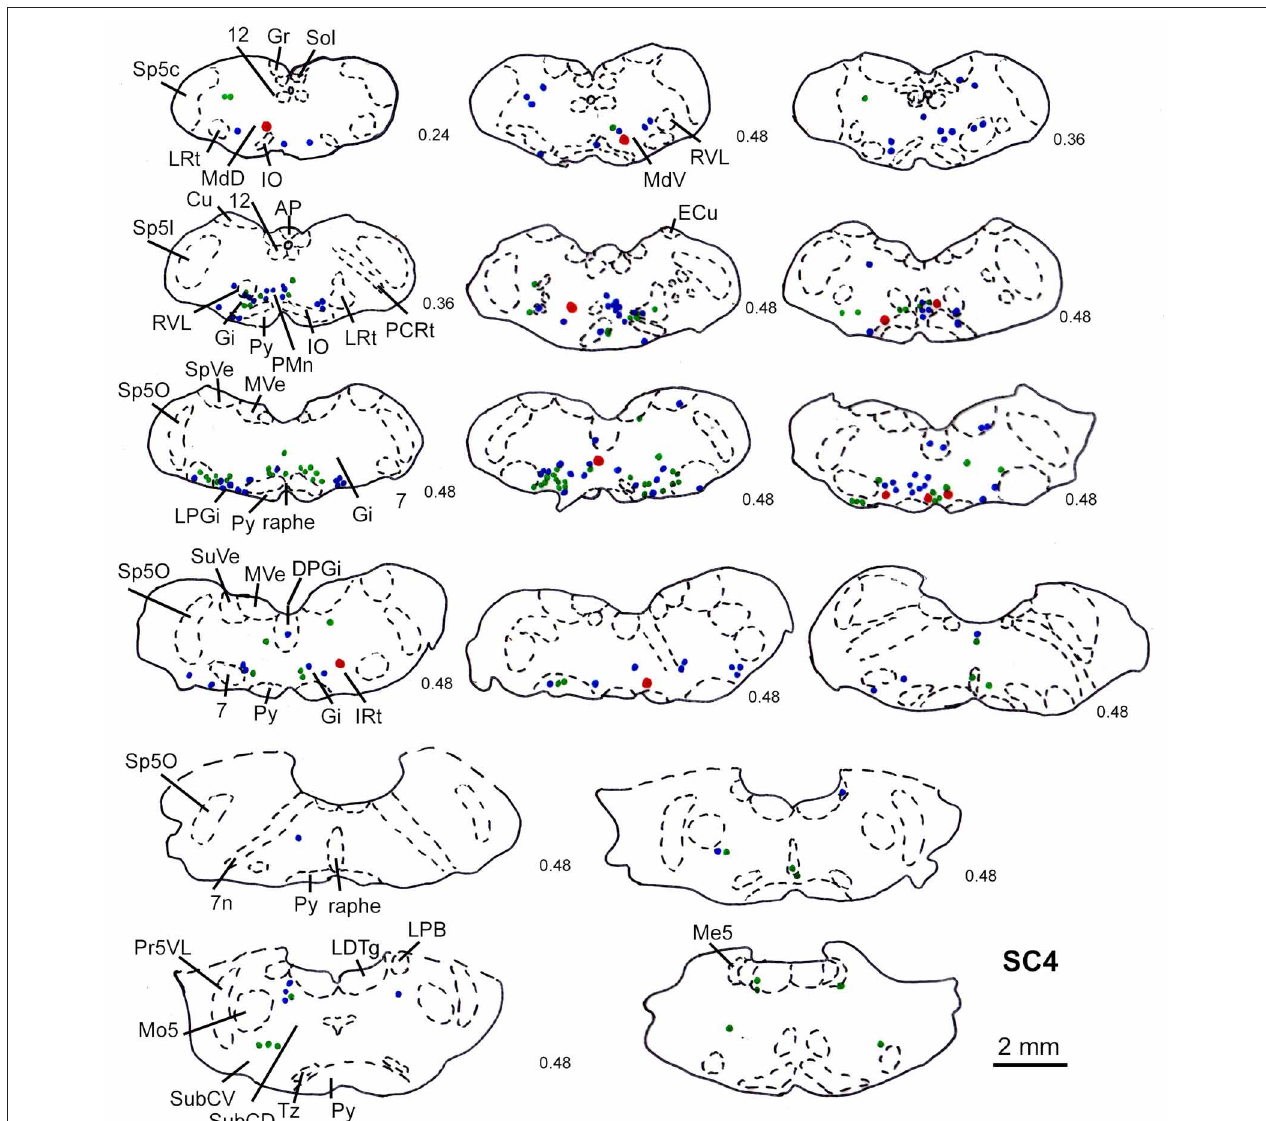
FIGURE 8 | Series of frontal sections through the brainstem and midbrain of case SC4 demarcating the location of retrogradely labeled neurons after inoculation of the left m. acromiodeltoideus (survival time of 79h after inoculation) and FITC labeled varicosities